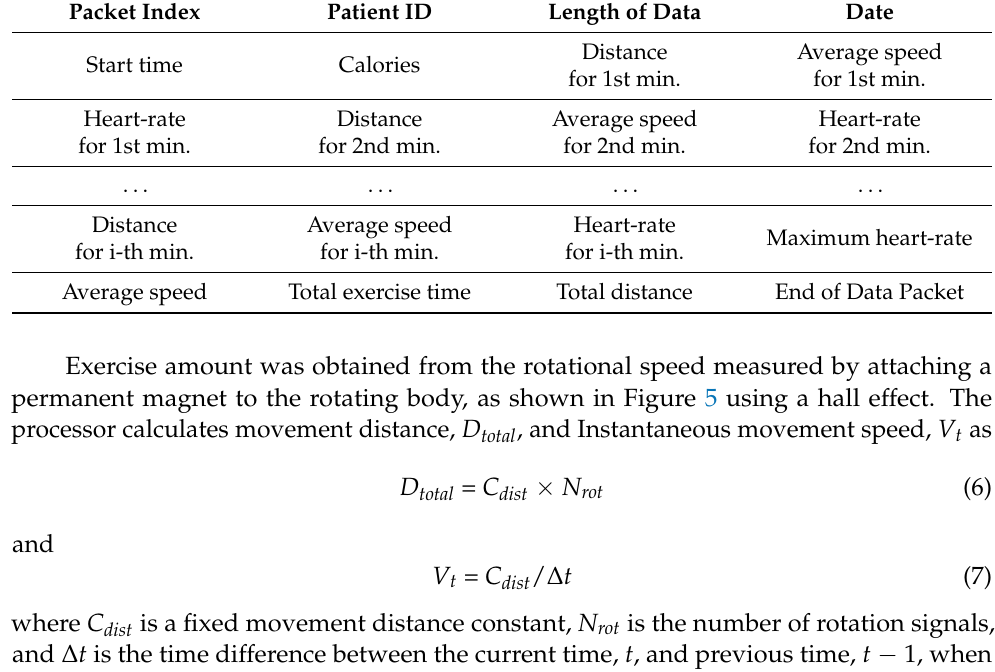
Figure 6. The data synchronization process between aerobic equipment and smartphone applica- tion in the proposed therapeutic exercise platform.